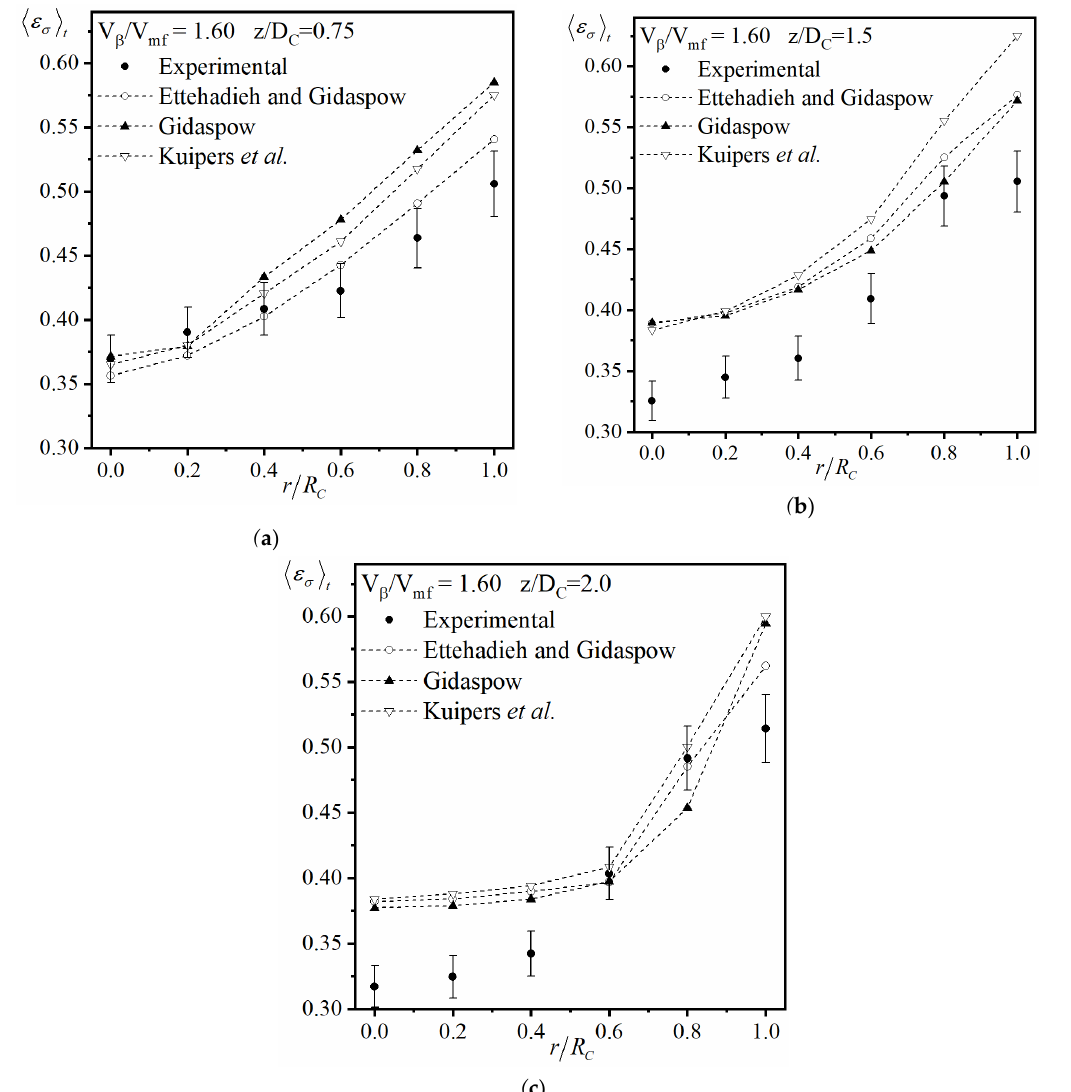
Figure 7. Prediction of the local radial solid holdup profile by using different modulus of elasticity sub-models at for a fluidized bed of D C = 14 cm, operating at / V mf = 1.60, at ( a ) z / D C = 0.75, ( b ) z / D C = 1.5 and ( c ) z / D C = 0 .